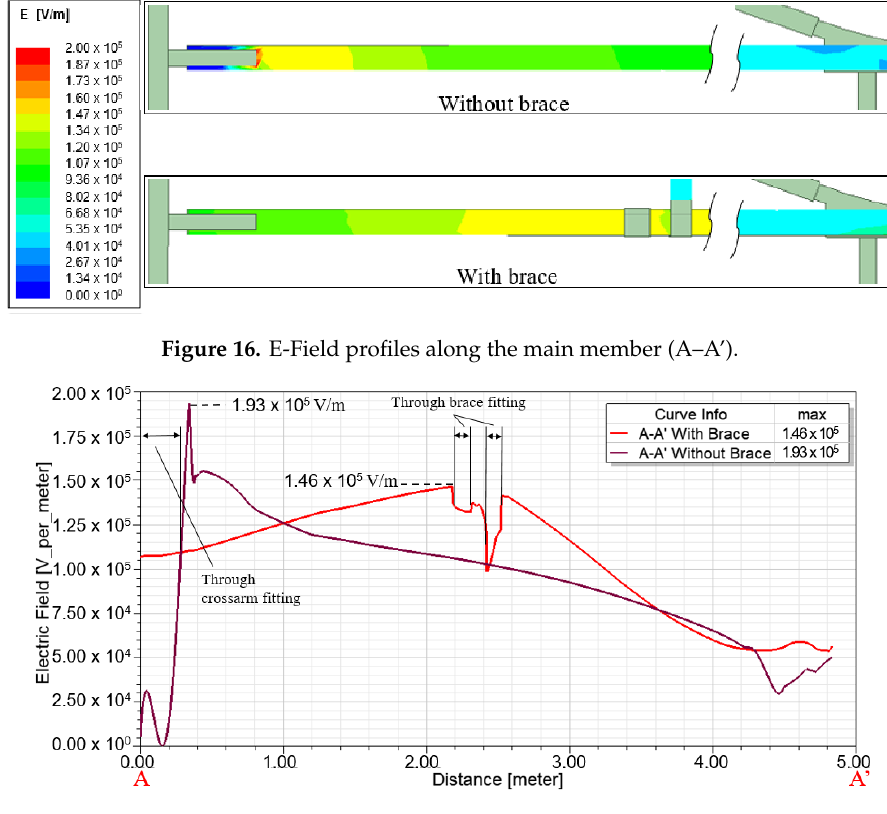
Figure 17. Changes of the E-Field magnitude along A –A’ due to brace installation.